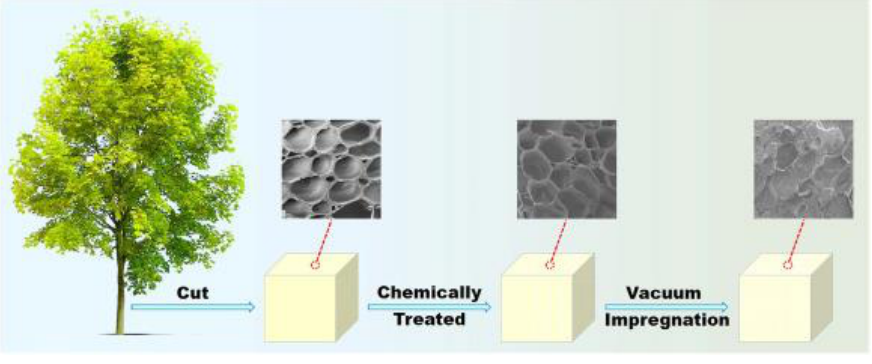
Figure 5. Diagram for the preparation of SSCPCMs